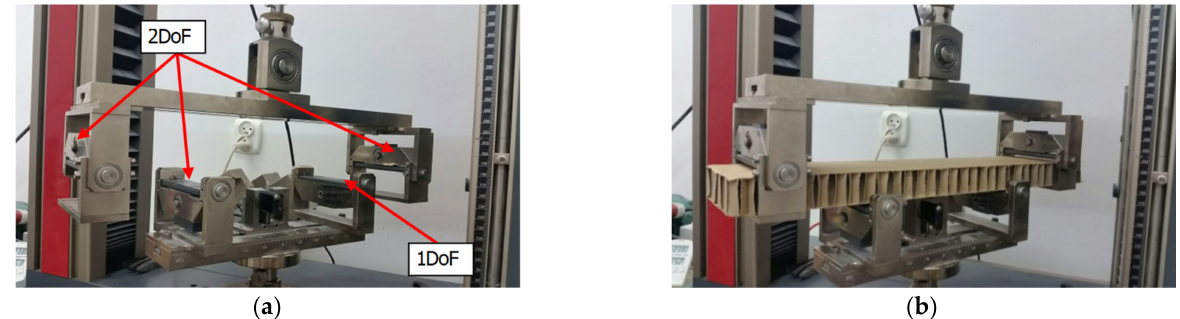
Figure 4. Tool for measuring bending stiffness ( a ) and a sample of the honeycomb board placed in the tool ( b )